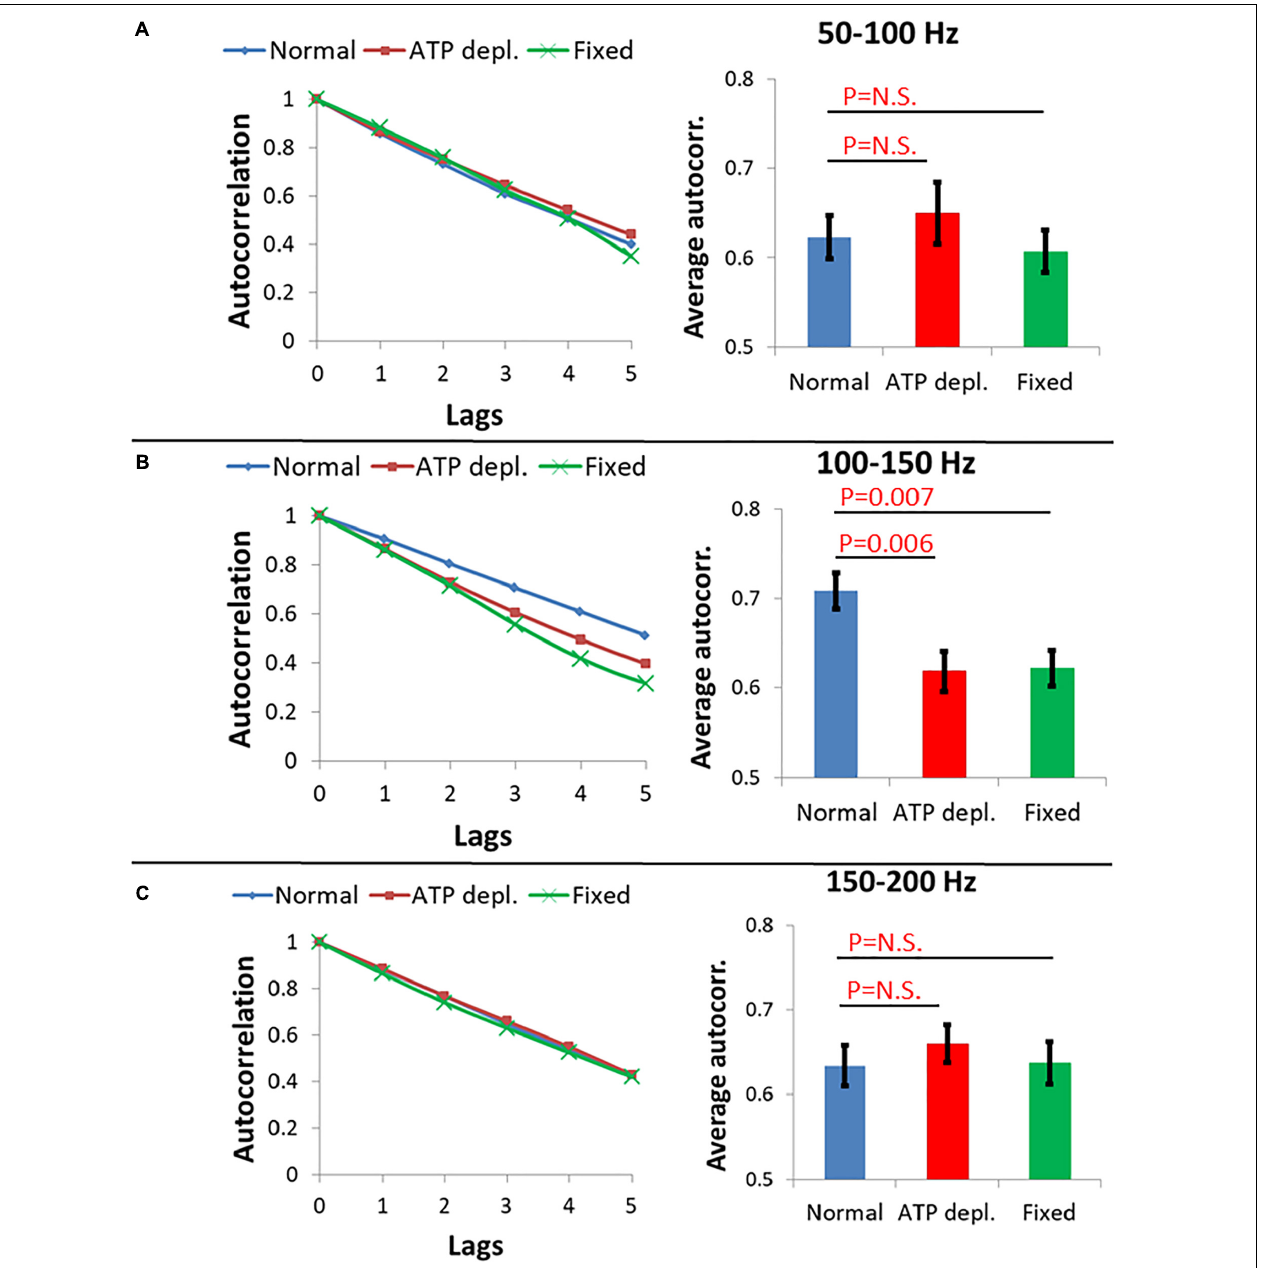
FIGURE 9 | Average autocorrelation results of Amplitude spectral density (ASD) analysis. (A) Average autocorrelation results of ASD in normal non-treated cells ( N = 14), adenosine triphosphate (ATP) depleted cells ( N = 14) and dead fixated cells ( N = 20) in the frequencies range between 50 and 100 Hz. Results relate to the spectral data in Figure 8 . On the right the average autocorrelation values of 1–5 lags in each cellular condition with their SD of mean are presented. (B) Average autocorrelation results of ASD in the normal non-treated cells, ATP depleted cells and dead fixated cells in the frequencies range between 100 and 150 Hz. On the right the average autocorrelation values of 1–5 lags in each cellular condition with their SD of mean are presented. (C) Average autocorrelation results of ASD in the normal non-treated cells, ATP depleted cells and dead fixated cells in the frequencies range between 150 and 200 Hz. On the right the average autocorrelation values of 1–5 lags in each cellular condition with their SD of mean are